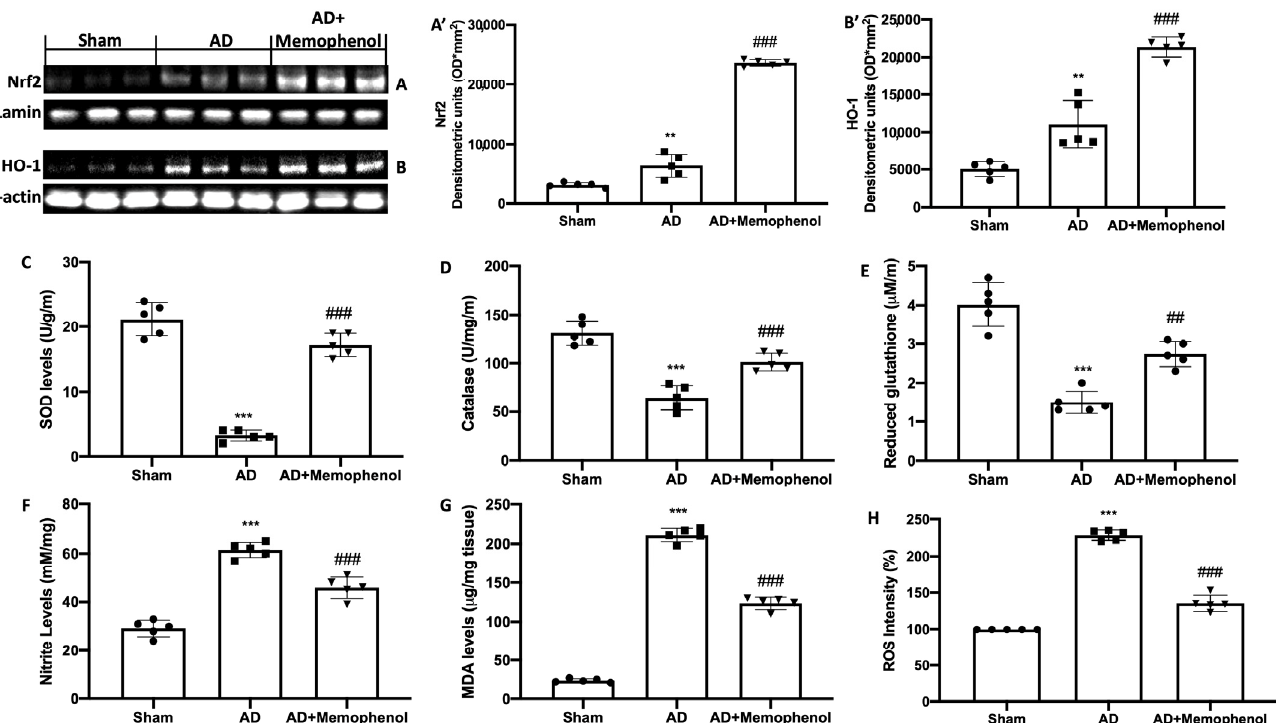
Figure 3. Memophenol TM administration decreased pro-oxidative modifications in the hippocampus. Western blot analysis of Nrf2 expression ( A ) and HO-1 ( B ) with related densitometric analysis ( A’ , B’ ), and biochemical analysis of SOD levels ( C ), CAT activity ( D ), GSH levels ( E ), nitrite levels ( F ), MDA levels ( G ), and ROS levels ( H ). For both analyses, n = 5 rats from each group and for each analysis were employed. A p -value of less than 0.05 was considered significant. ** p < 0.01 versus Sham, *** p < 0.001 versus Sham, ## p < 0.01 versus AD, ### p < 0.001 versus AD.